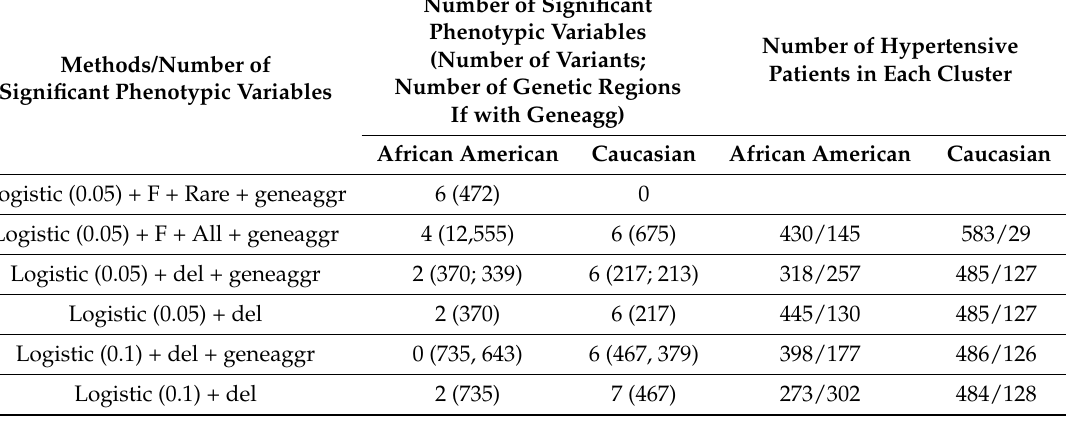
Table 4. The first half is the summary of number of significant phenotypic variables and number of variants selected to do the clustering analysis using different combinations of filtrations. The second half summarizes the number of hypertensive patients in each subgroup under different combinations of